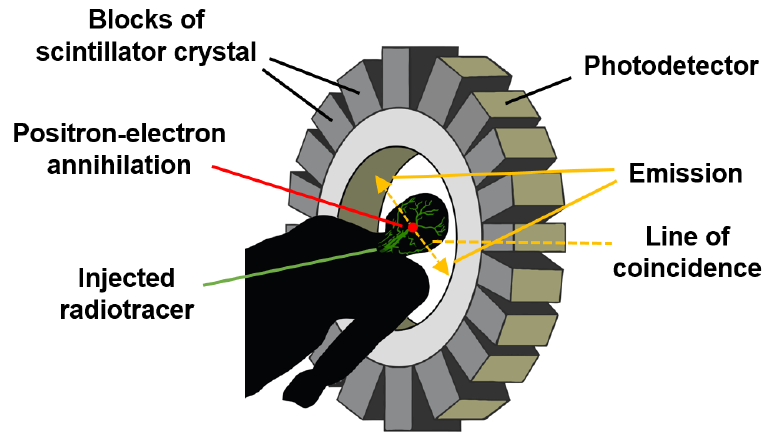
Figure 14. Diagram of a positron emission tomography scanner.